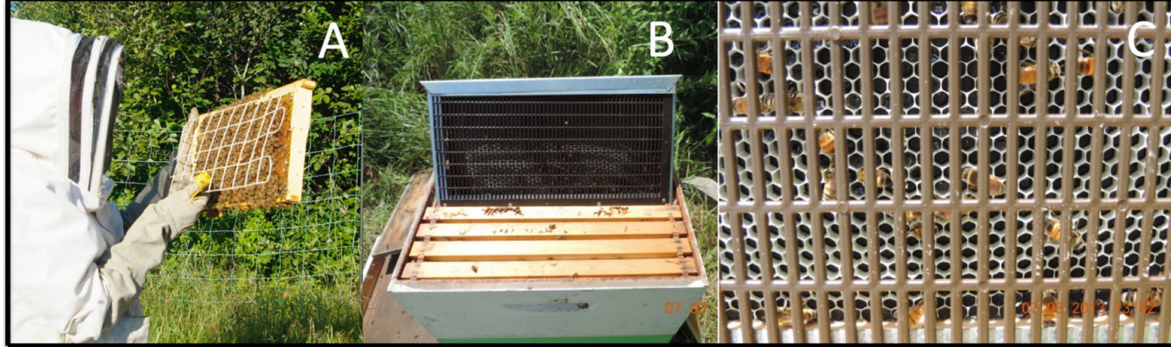
Figure 2. Grid for assessing sealed brood and worker population on frames ( A ), Queen cage for assessing oviposition rate ( B ), and closeup of queen cage ( C